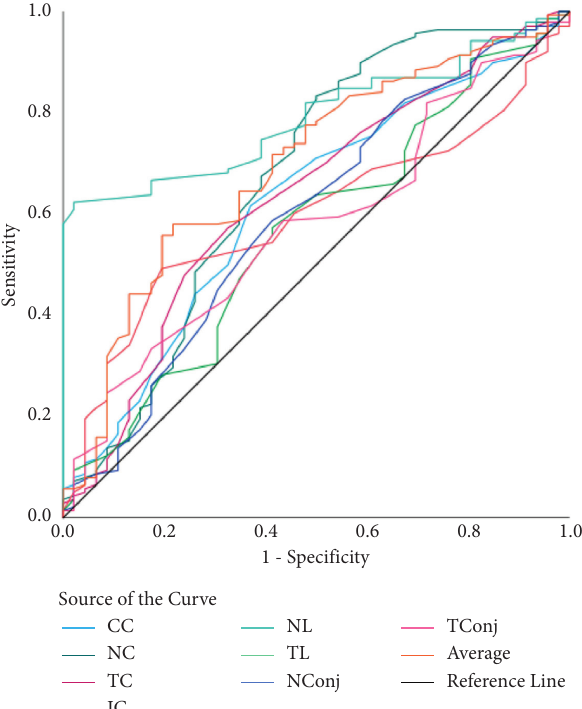
Figure 2: ROC curves of ocular surface temperature for nondry eye disease. ROC curves represent the dry eye disease group (mild dry eye, moderate dry eye, and severe dry eye) vs. the nondry eye group.